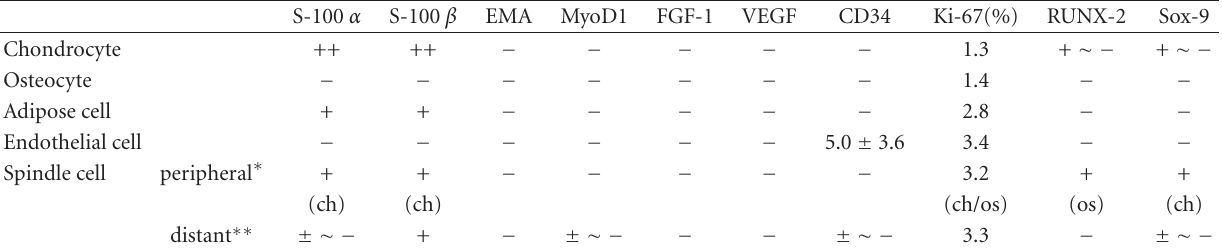
Table 1: Immunohistochemistry findings of the 2 cases of oral lipoma with osseous/chondroid di ff erentiation.